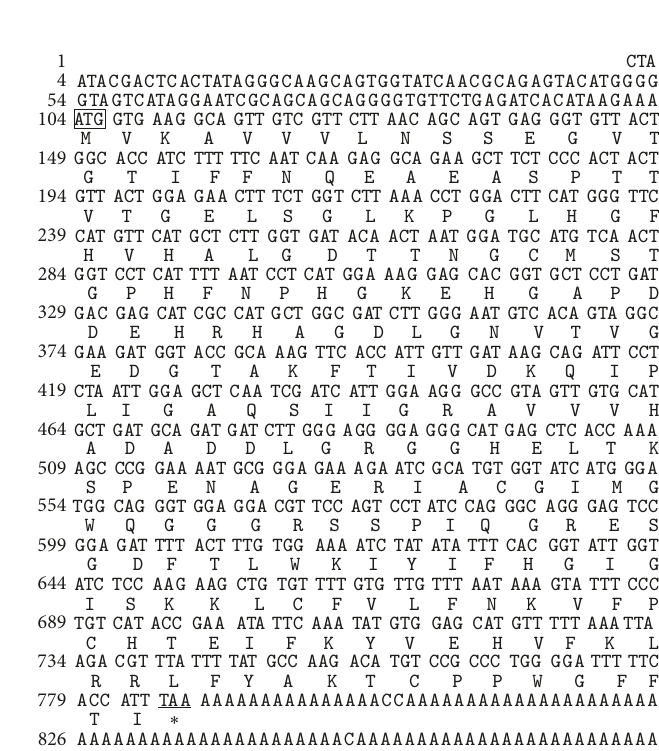
Figure 1: The full-length cDNA sequence and deduced amino acid sequence of G. bicolor Cu/Zn SOD. The start codon (ATG) is boxed and the stop codon (TAA) is